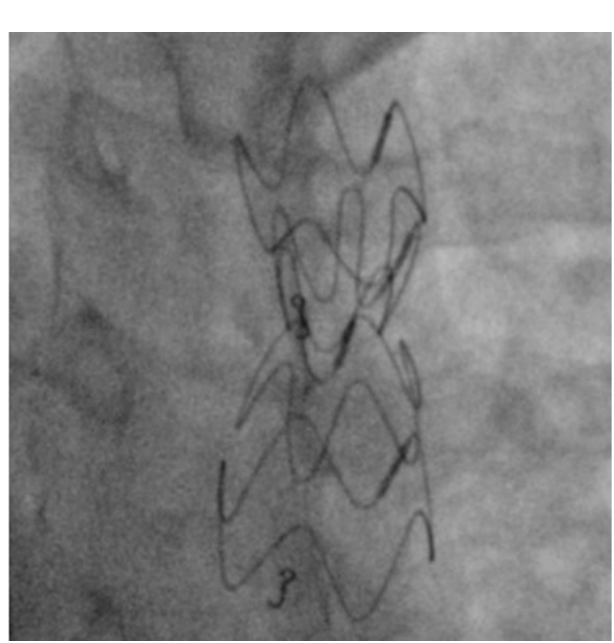
Fig. 4 – Dominus® Coarctation Aorta endoprosthesis released under fluoroscopic control, with no need of post-dilatation. Magnification shows the expanded